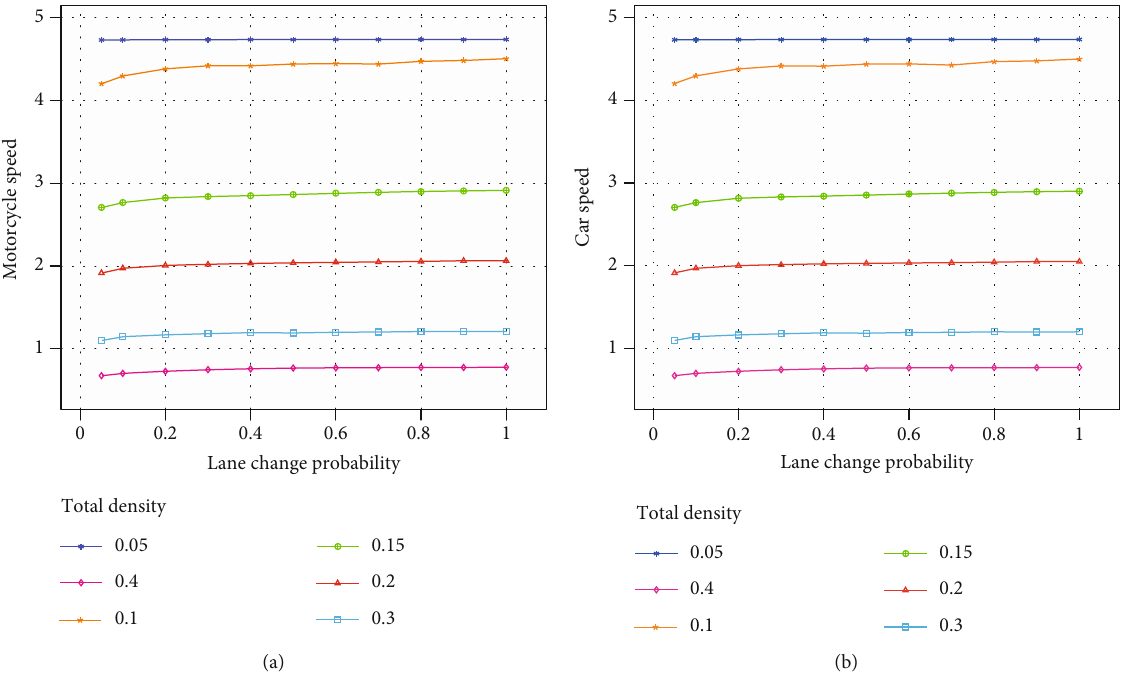
Figure 5: (a) Motorcycle speed V/s lane change probability diagrams with sp = 0 : 25 for di ff erent total densities. (b) Car speed V/s lane change probability diagram with sp = 0 : 25 for di ff erent total